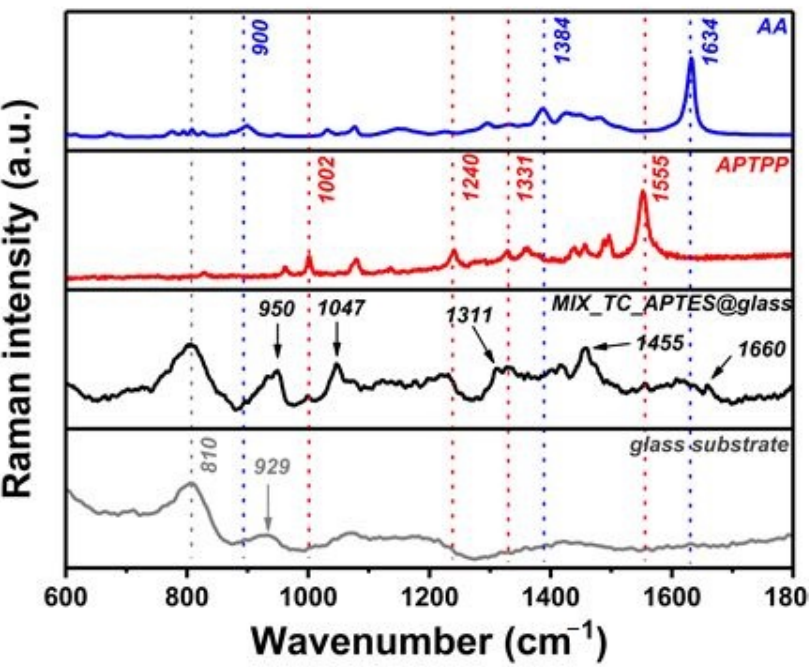
Figure 4. Raman spectra recorded for AA, APTPP, modified (MIX_TC_APTES@glass), and unmodified glass substrate.